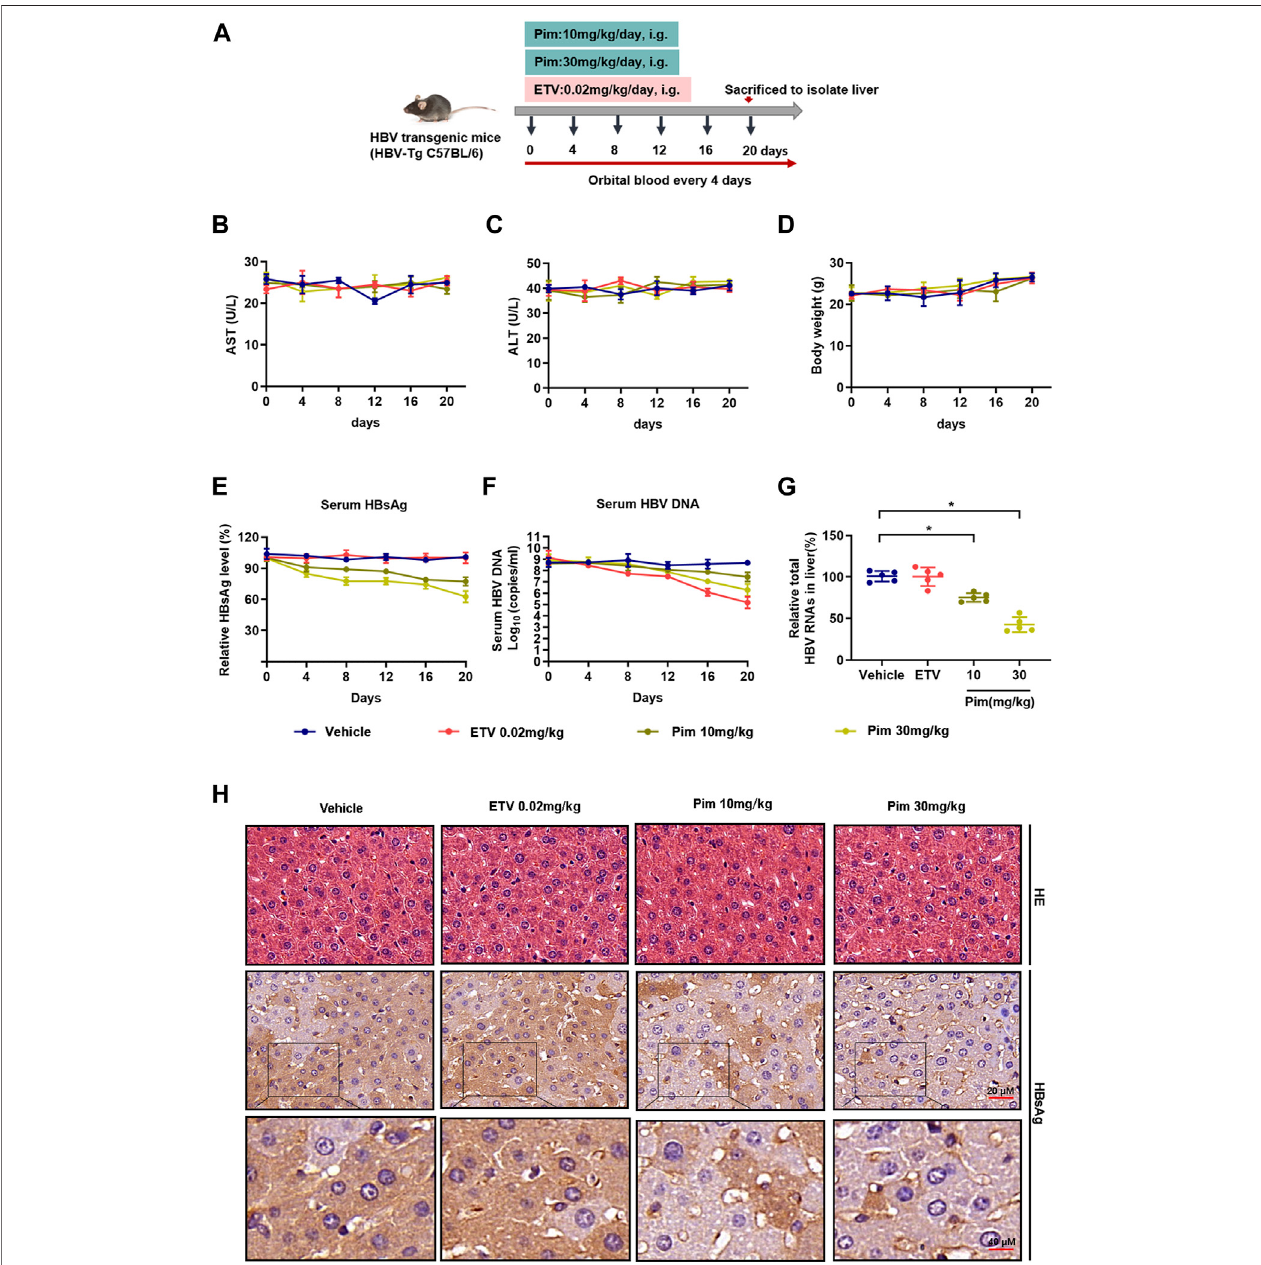
FIGURE6| Anti-HBVactivityofPim invivo (A) FlowchartexplainingthewayandconcentrationofPimandETVadministrationaswellastheintervalsoforbitalblood collection, inHBV transgenic mouse model (B – C) The level ofALT and ASTwere detected by colorimetric microplateassay (D) The bodyweight withPim administration was monitored (E) Serum HBsAg was quanti fi ed by ELISA assay (F) Serum HBV DNA was detected by quanti fi cation PCR (G) Total HBV RNAs in the liver tissue were determined by real-time PCR (H) Representative images of immunohistochemistry of HBsAg in liver tissue. HE staining of all groups as a control (* p < 0.05; ** p <